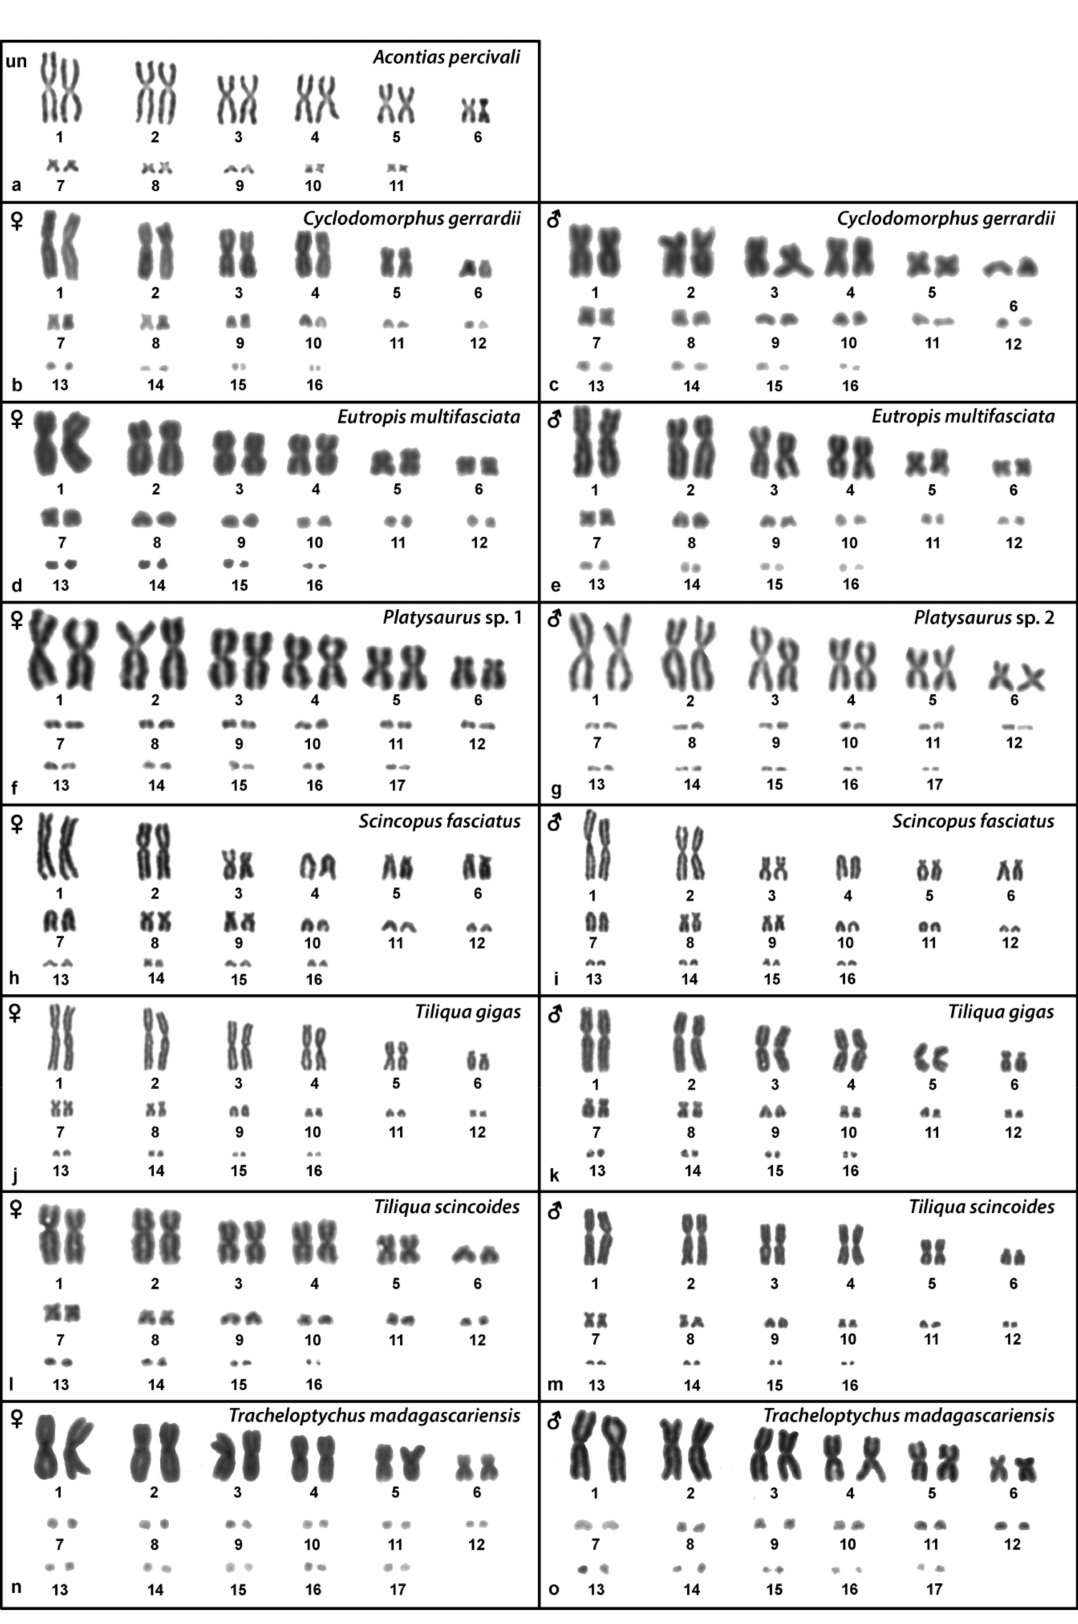
Figure 1. Giemsa-stained karyograms of Acontias percivali ( a ), Cyclodomorphus gerrardii ( b , c ), Eutropis multifasciata ( d , e ), Platysaurus sp. 1 ( f ), Platysaurus sp. 2 ( g ), Scincopus fasciatus ( h , i ), Tiliqua gigas ( j , k ), Tiliqua scincoides ( l , m ), and Tracheloptychus madagascariensis ( n , o ). UN: sex not